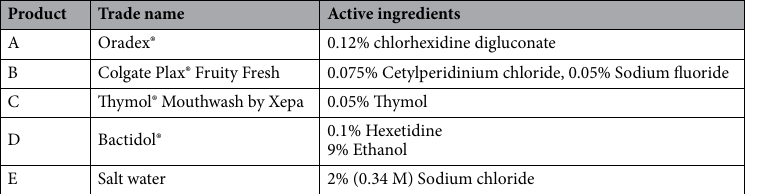
Table 1. List of mouthwash/gargle